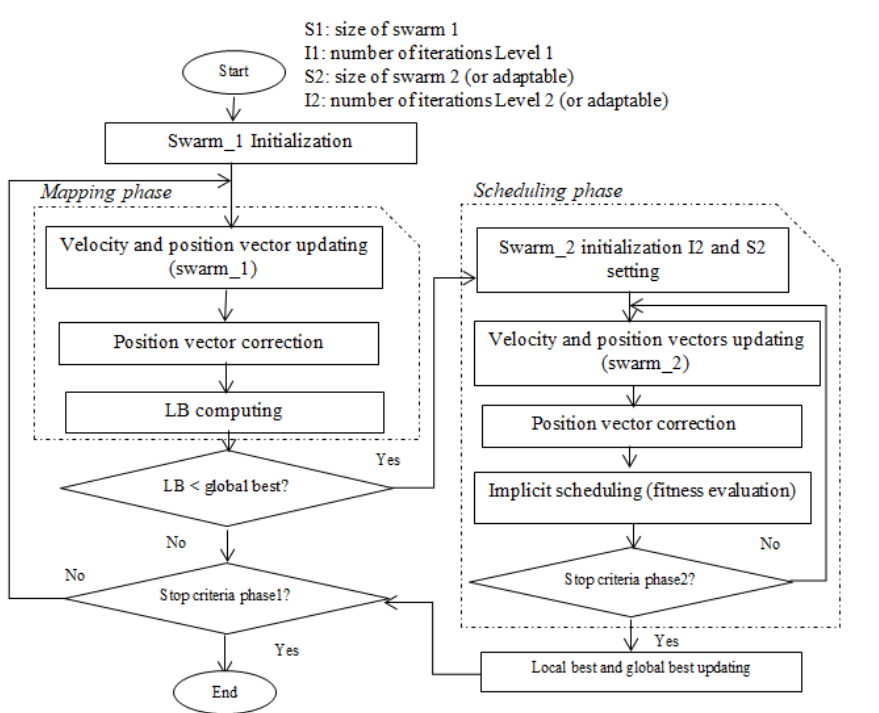
Figure 3. Flowchart of the two-level particle swarm optimizatiom—flexible job shop scheduling problem